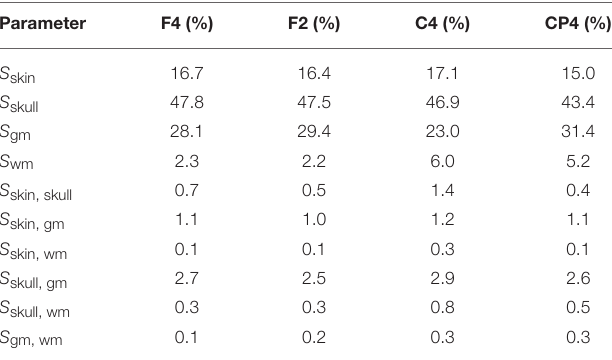
TABLE 2 | First- and second-order Sobol